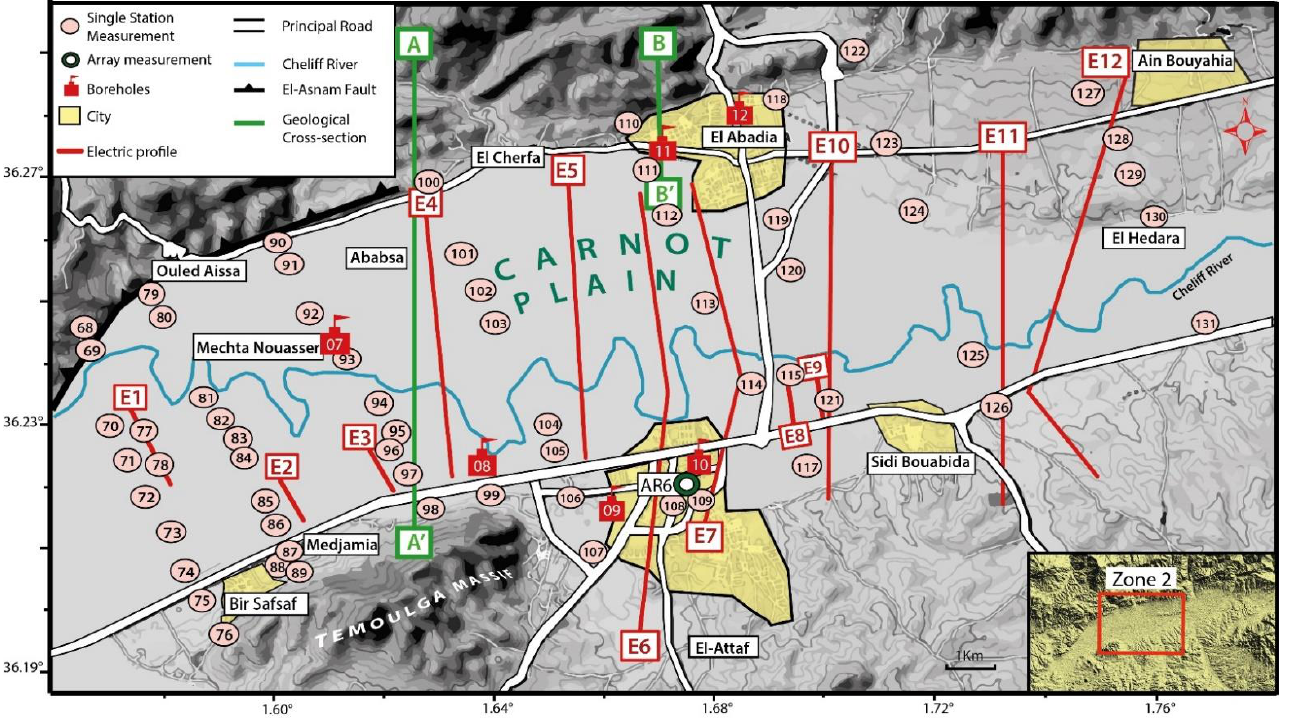
Figure 4. Compiled data in Zone 1.